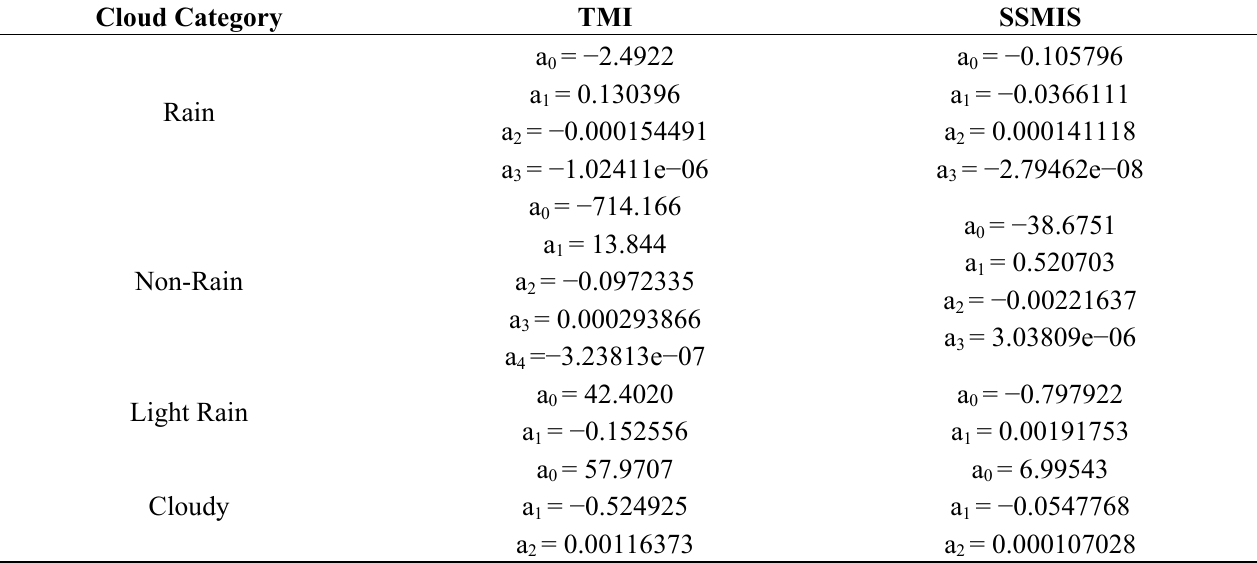
Table 1. Calibration coefficients of TMI 85-H GHz and SSMIS 91-H GHz to AMSR-E 89-H GHz using a polynomial function with four cloud categories.